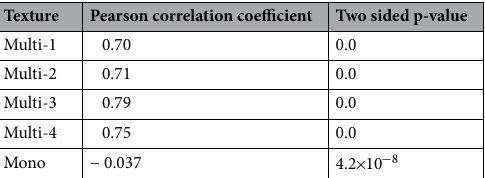
Table 1. A statistical analysis of the pixel level data after image registration between the intensity measure by the scanner and the LOANA.